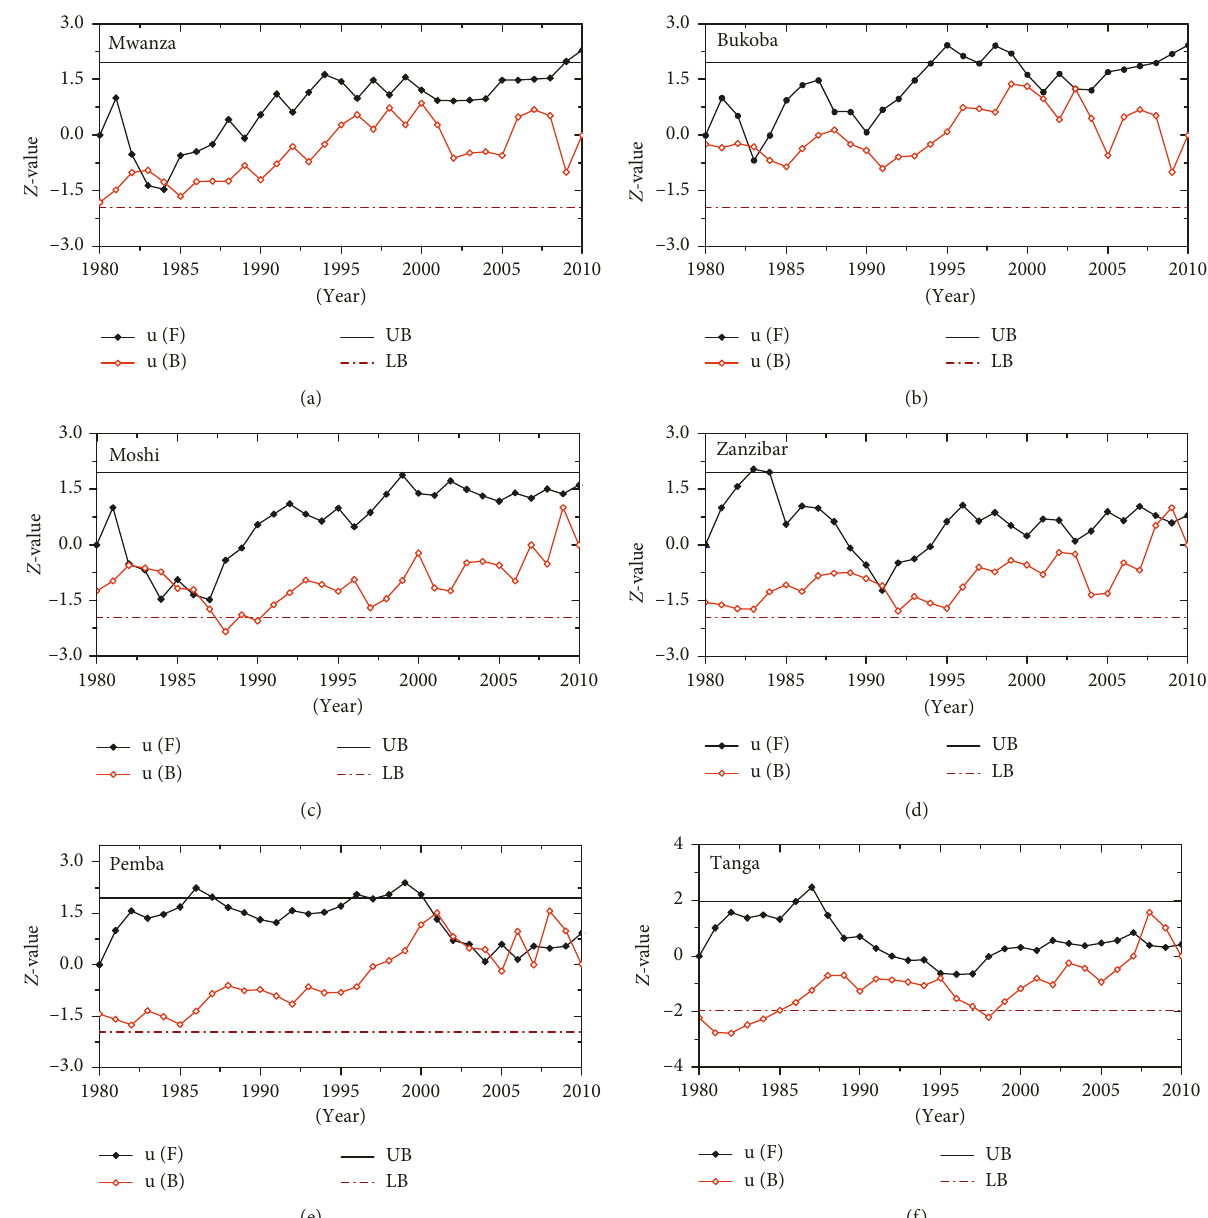
Figure 3: Sequential Mann–Kendall tests of annual heavy rainfall over (a, b) Lake Victoria basin, (c) NEH, and (d–f) northern coast. Dotted and solid horizontal lines indicate critical values corresponding to 95% confidence